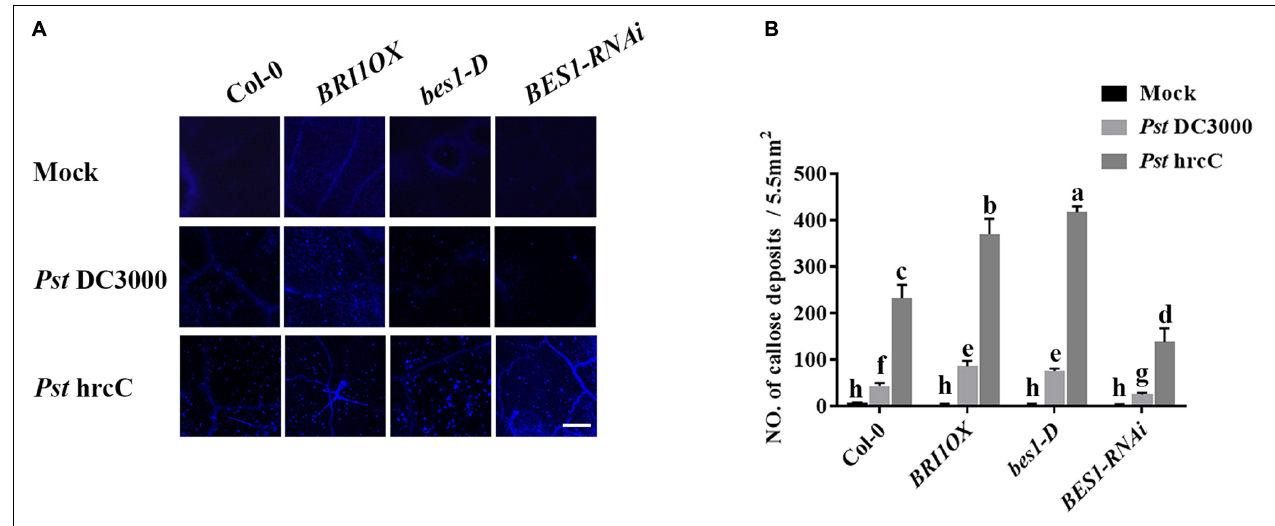
FIGURE 8 | Brassinosteroid signaling induces callose deposition after infection. (A) Callose deposition in Col-0, BRI1OX , bes1-D , and BES1-RNAi infected leaves at 1 dpi. Callose deposition was visualized by fluorescence microscopy. Bar, 200 µ m. (B) Number of callose deposition in the 5.5 mm 2 microscopic fields. Callose deposition was counted in 8–12 microscopic fields of 5.5 mm 2 from 8 to 12 different leaves and three biological repeats. Significant differences ( P < 0.05) are denoted by different lowercase